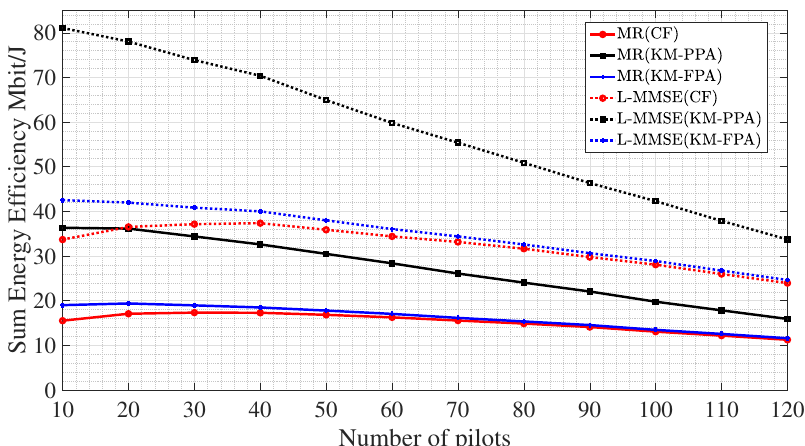
Figure 4. The sum energy efficiency versus the number of pilots; APs equipped with multiple